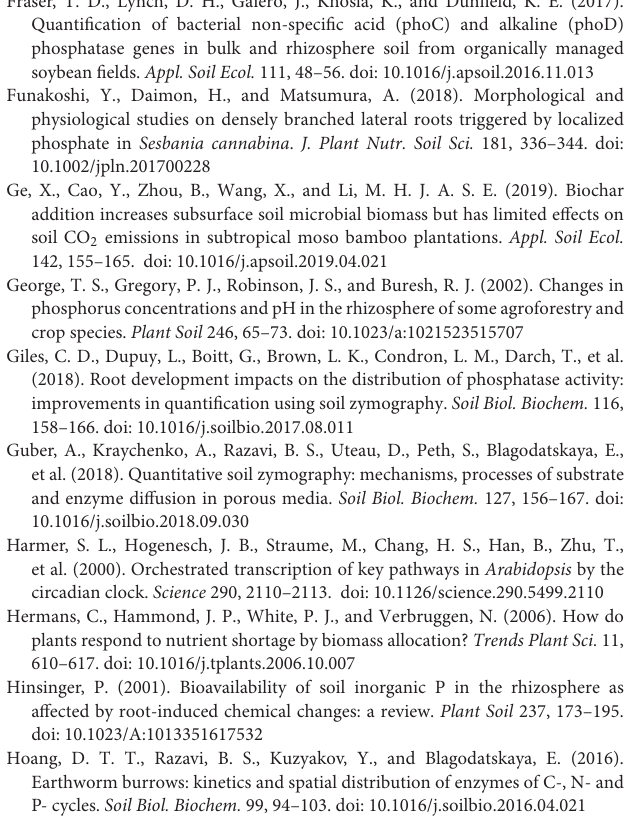
Supplementary Figure 1 | Schematic diagram of the experimental rhizobox and the location of the P-rich patch (the brown cycle). Supplementary Figure 2 | Root mass ratio (A) and root tissue density (B) of maize on 30 DAS in fluvo-aquic soil and red soil. Capital letters indicate significant differences between different soil types, and lower-case letters indicate significant differences between fertilization treatments. Each column refers to the mean value of four replicates ( +